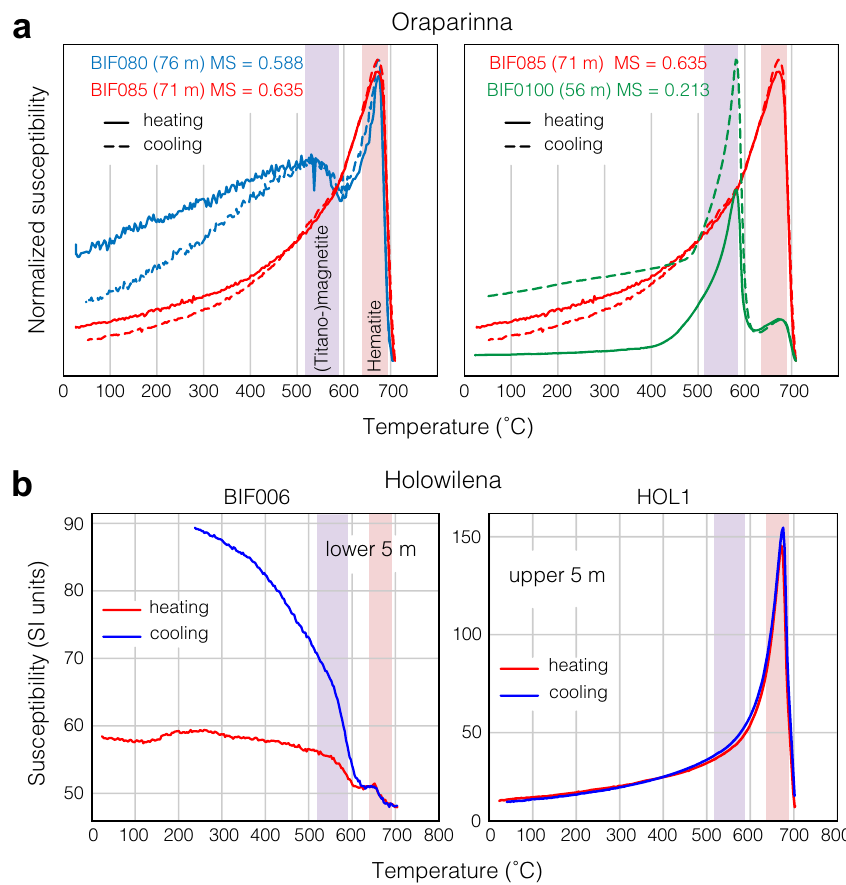
Fig. 5 Thermal susceptibility experiments. a Oraparinna. Thermal susceptibility comparison between samples across a short eccentricity cycle (~100 kyr; left) and a long eccentricity cycle (~400 kyr; right). Stratigraphic heights relate to the Oraparinna section (Fig. 2). Unblocking temperatures near ~675 ˚ C and ~585 ˚ C indicates the presence of hematite and magnetite, respectively. Note hematite is dominant, but magnetite content is variable. Hematite-pure lithologies yield high magnetic susceptibilities and hematite-poor lithologies yield low susceptibilities. b Holowilena. Sample BIF006 from the lower 5 m of the section (Supplementary Fig. 1) exhibits a dominant magnetite peak and subordinate hematite peak, whereas sample HOL-1 from the upper 5 m contains pure hematite. Supplementary Fig. 10 shows the results of other, corroborating rock magnetic experiments. Purple and red vertical bands in the background show typical ranges of (titano-)magnetite and hematite,